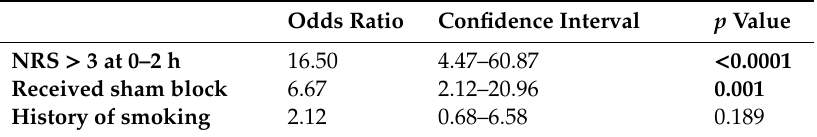
Table 3. Risk assessment for emergence agitation. NRS, numerical rating